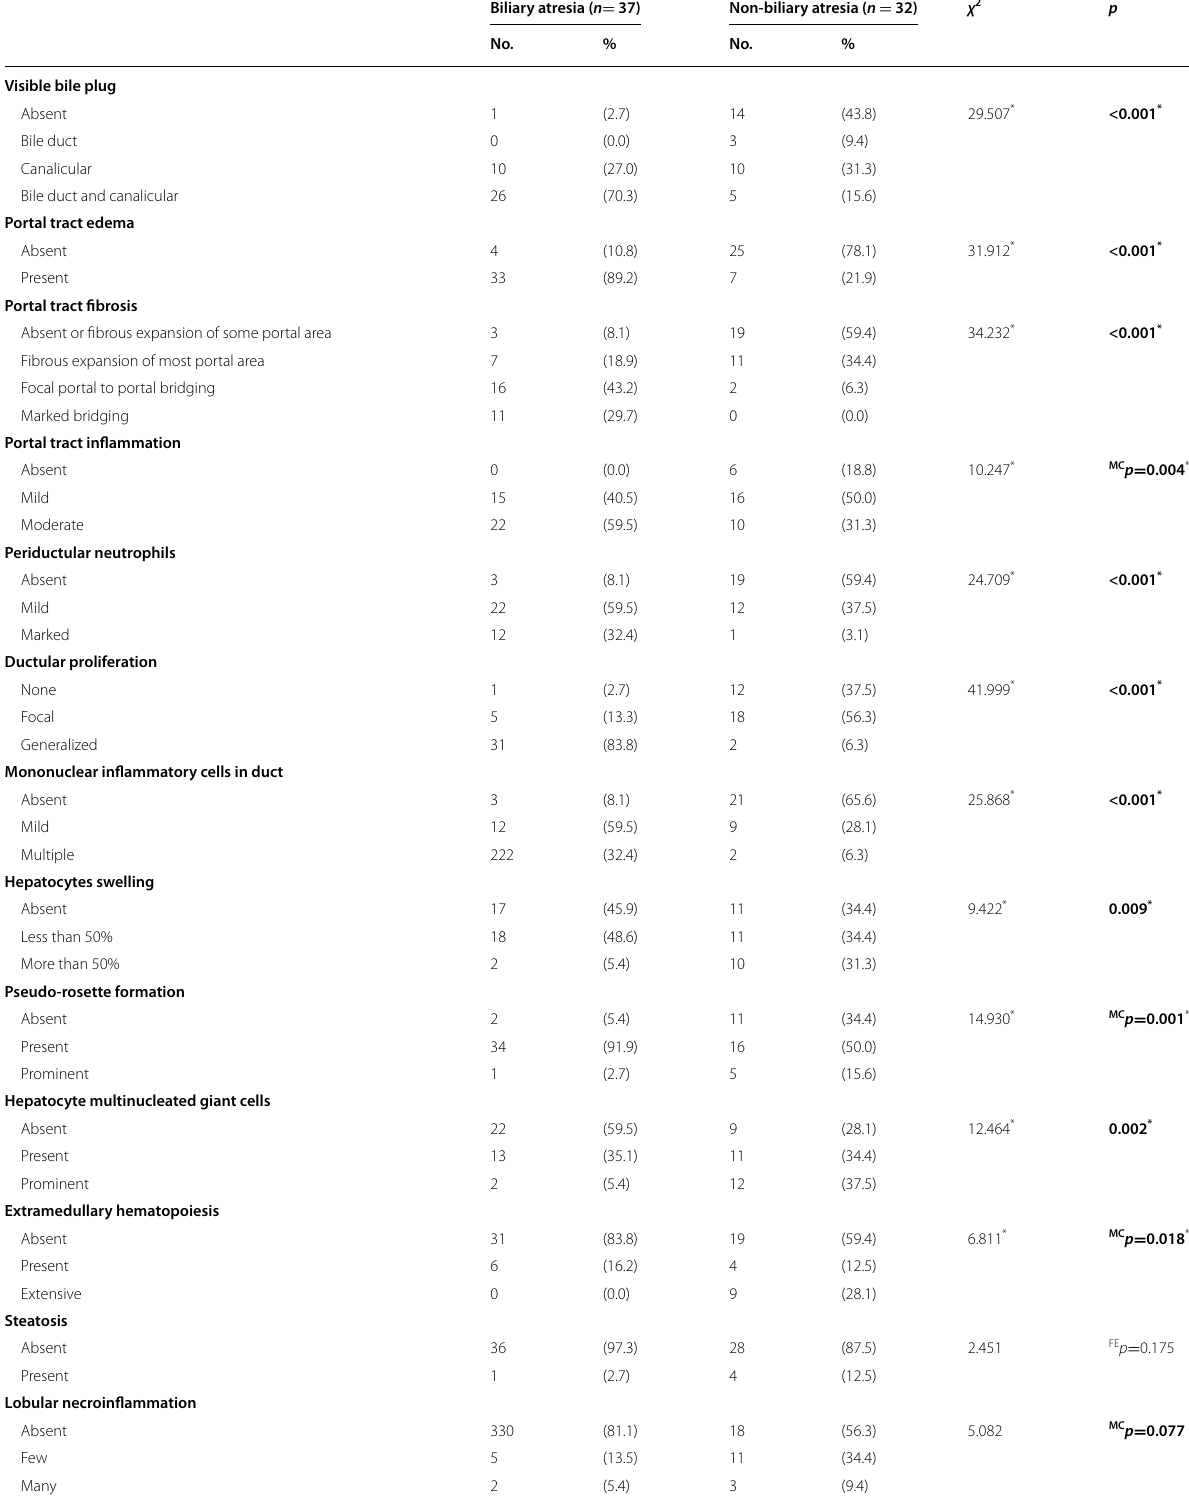
Table 2 Comparison between the pathological findings in the two cholestatic groups (biliary atresia and non‑biliary)